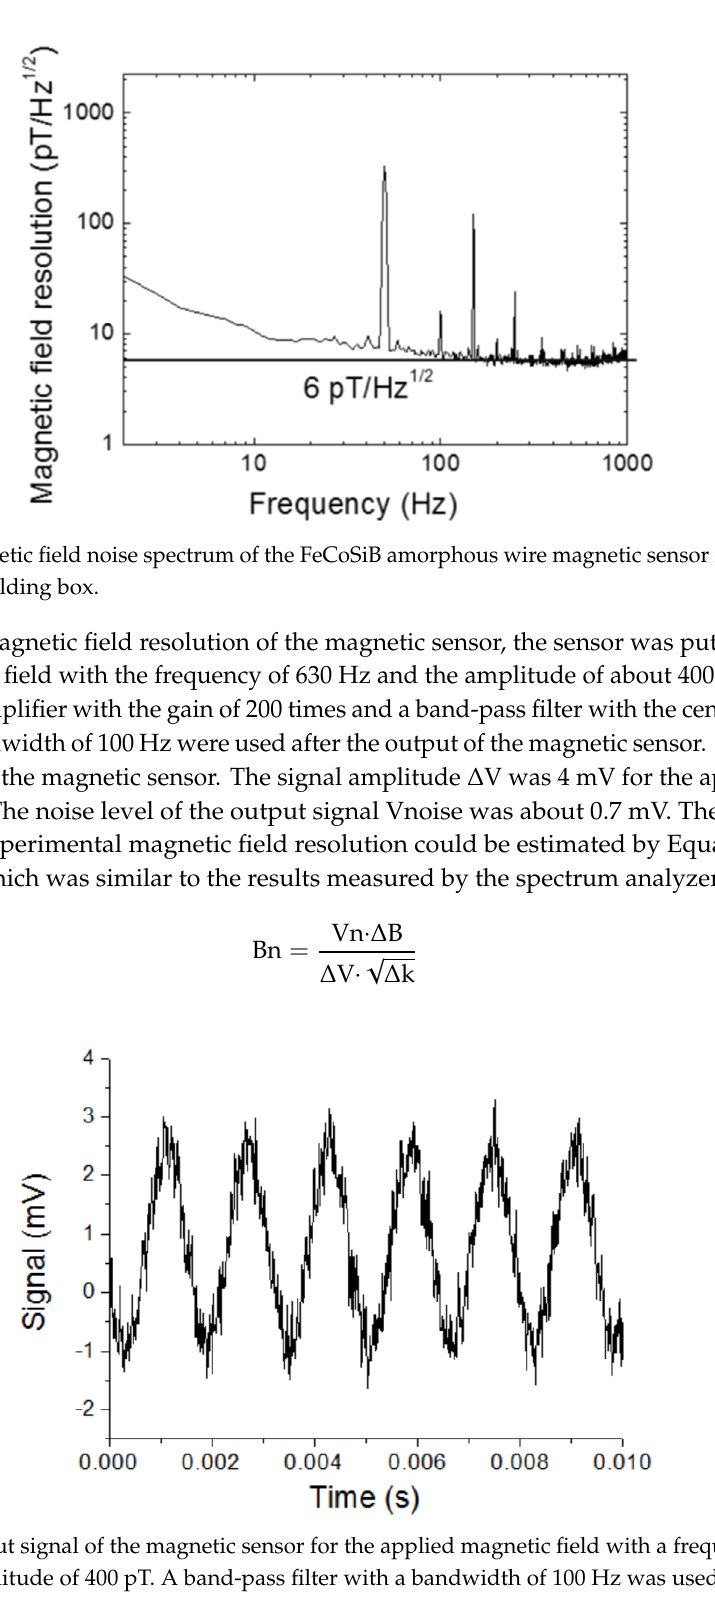
Figure 13. The magnetic field noise of the magnetic sensor at 630 Hz with the observation bandwidth of about 100 Hz.